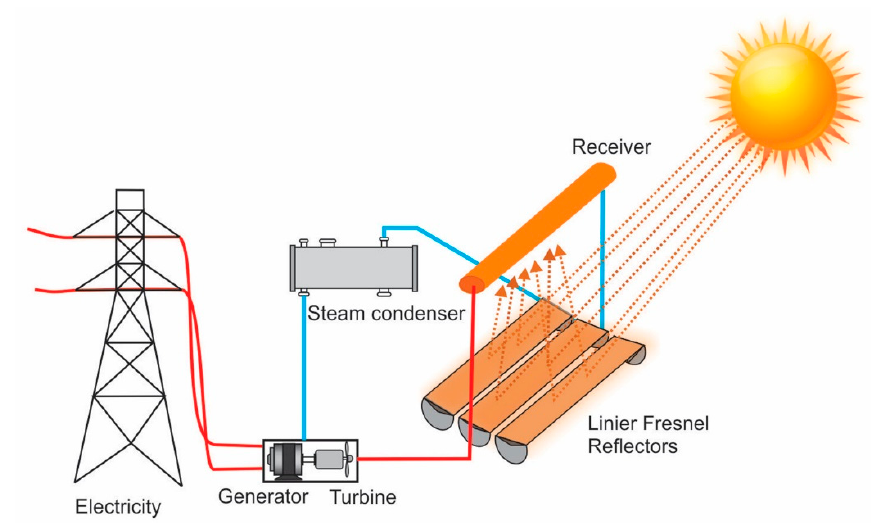
Figure 12. Solar thermal electricity by linear Fresnel reflectors.